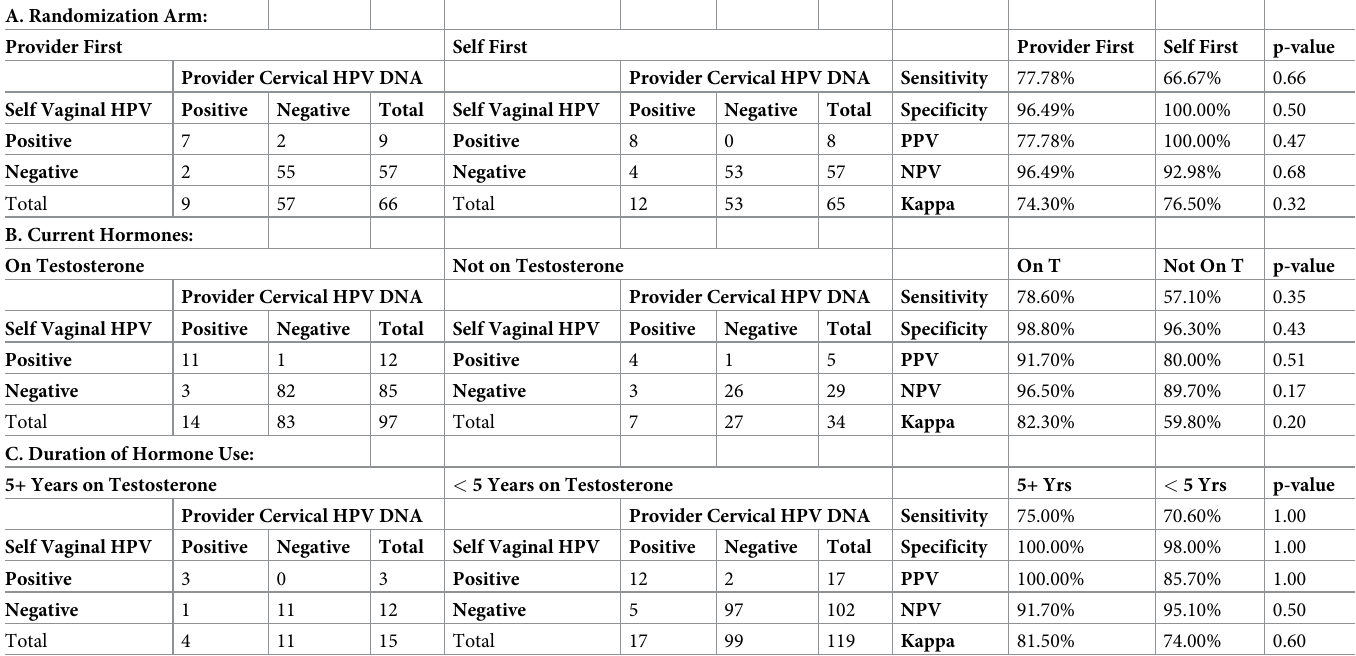
Table 4. Sensitivity analyses by randomization arm, current hormone use, and duration of hormone use: Concordance of self-collected vaginal HPV DNA hybrid- ization assay and provider-collected cervical HPV DNA specimen (gold standard). A. Randomization Arm: